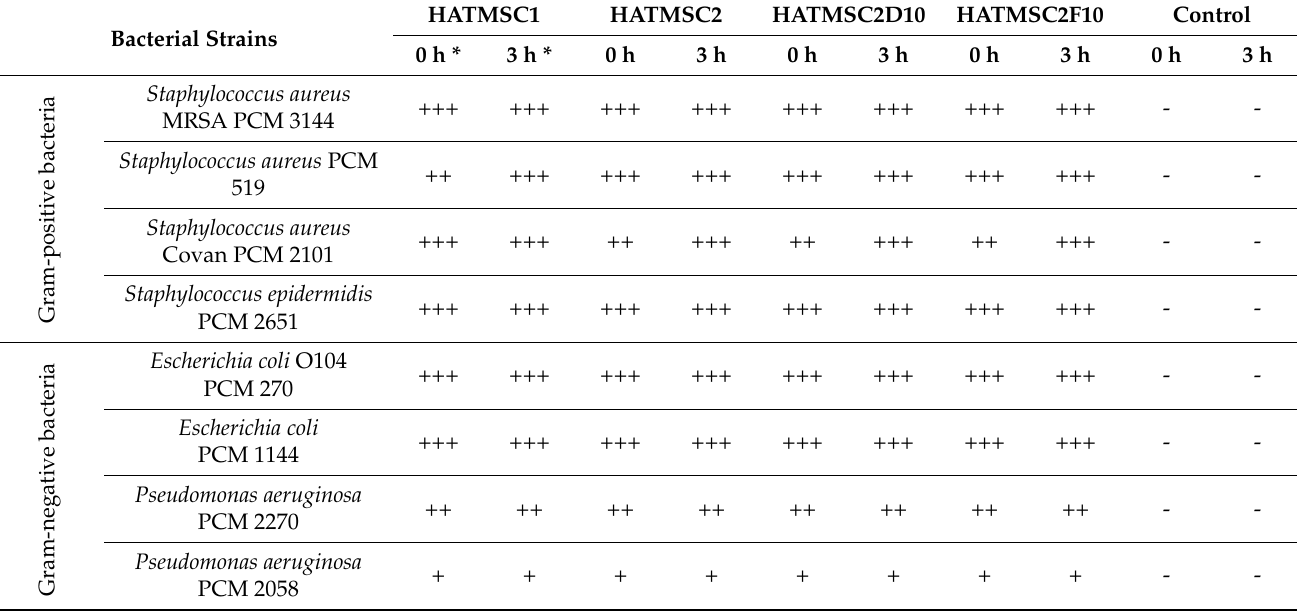
(+++)—completely bacterial growth inhibition; (++)—moderate bacterial growth inhibition; (+)—weak bacterial growth inhibition; (-)—no bacterial growth inhibition; (*)—time of application of HATMSCs supernatant following application of bacteria on agar